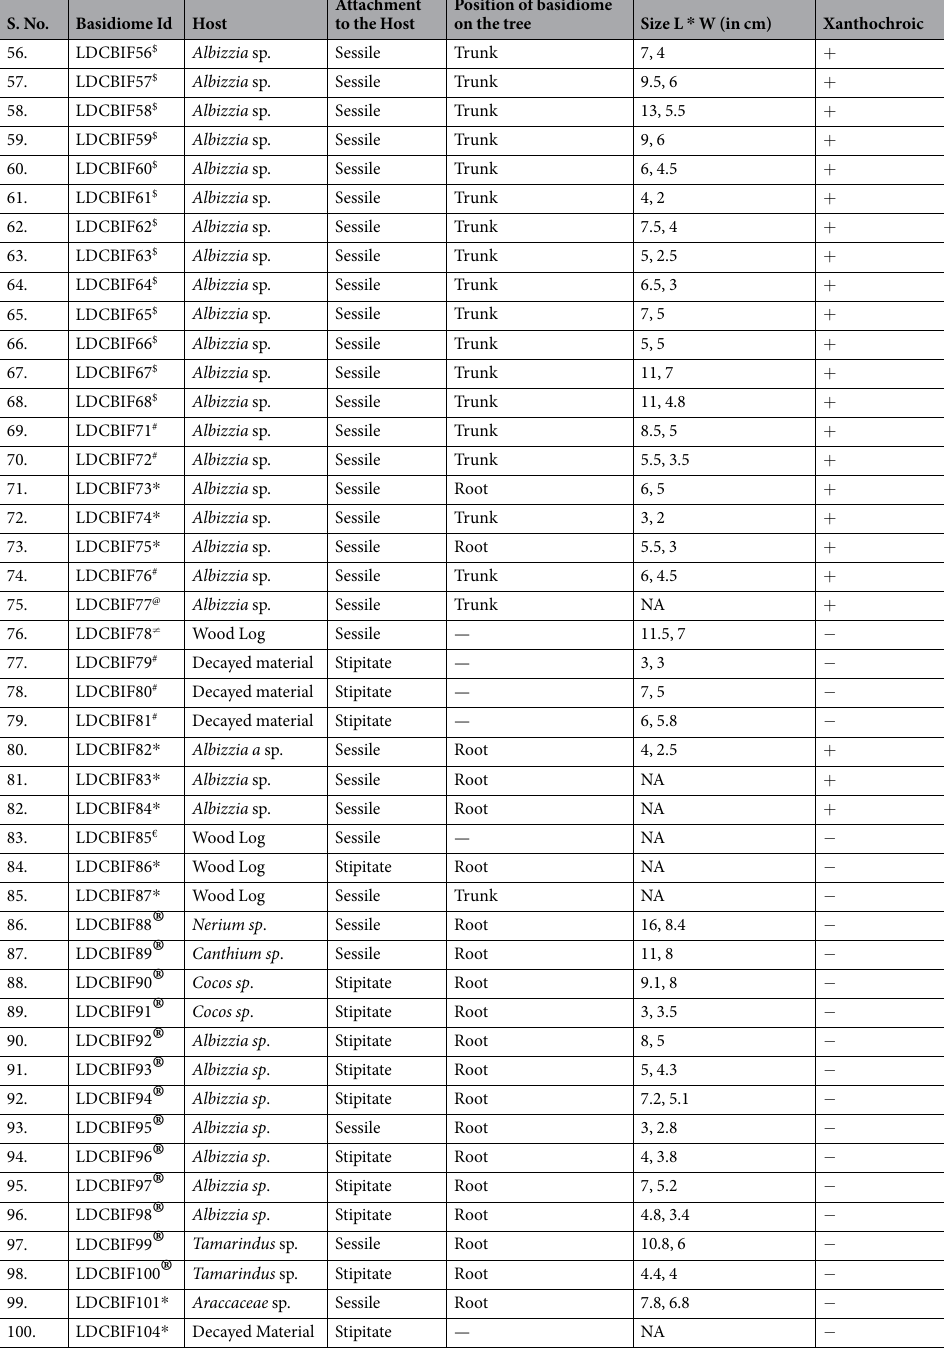
Table 1. Basidiomata collected. $, €, * , #, ≠ , @, ® used to denote the strains collected from different places. $